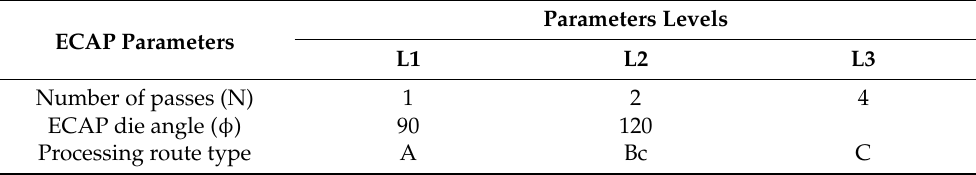
Table 1. ECAP parameters